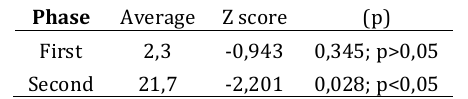
Table 4 Psychological burden scale measurement results